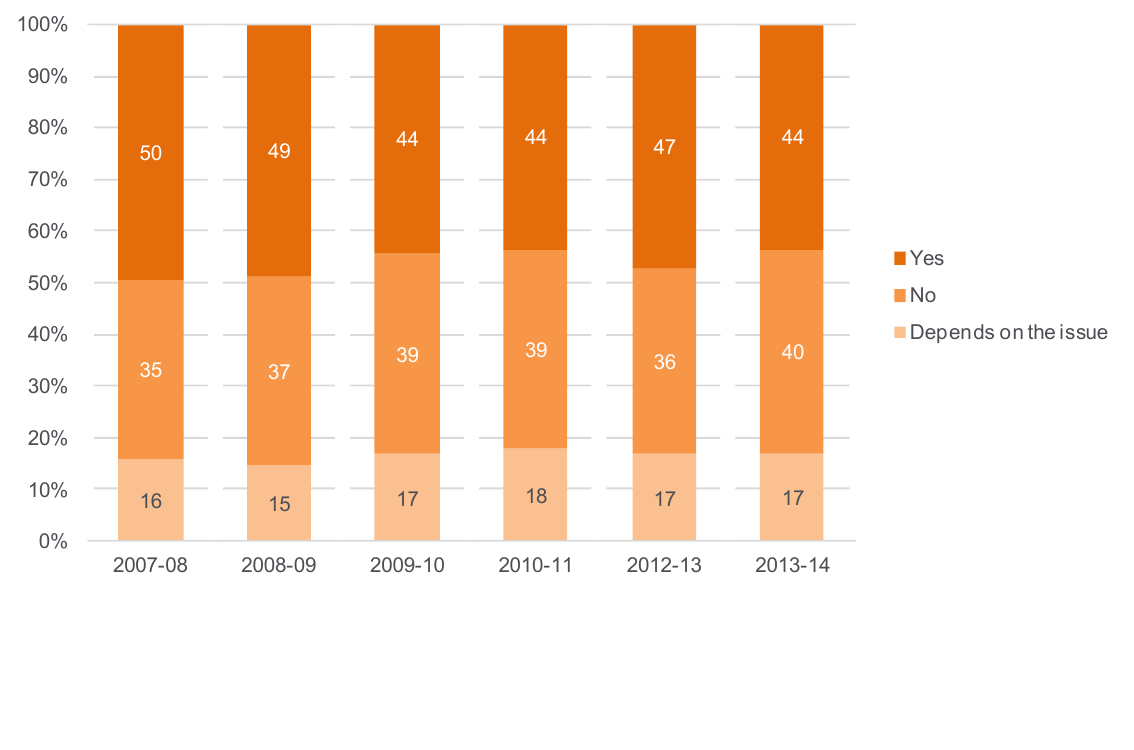
- Table 17: Whether people would like to be more involved in decisions made by their local council, 2007-08 to 2013-14